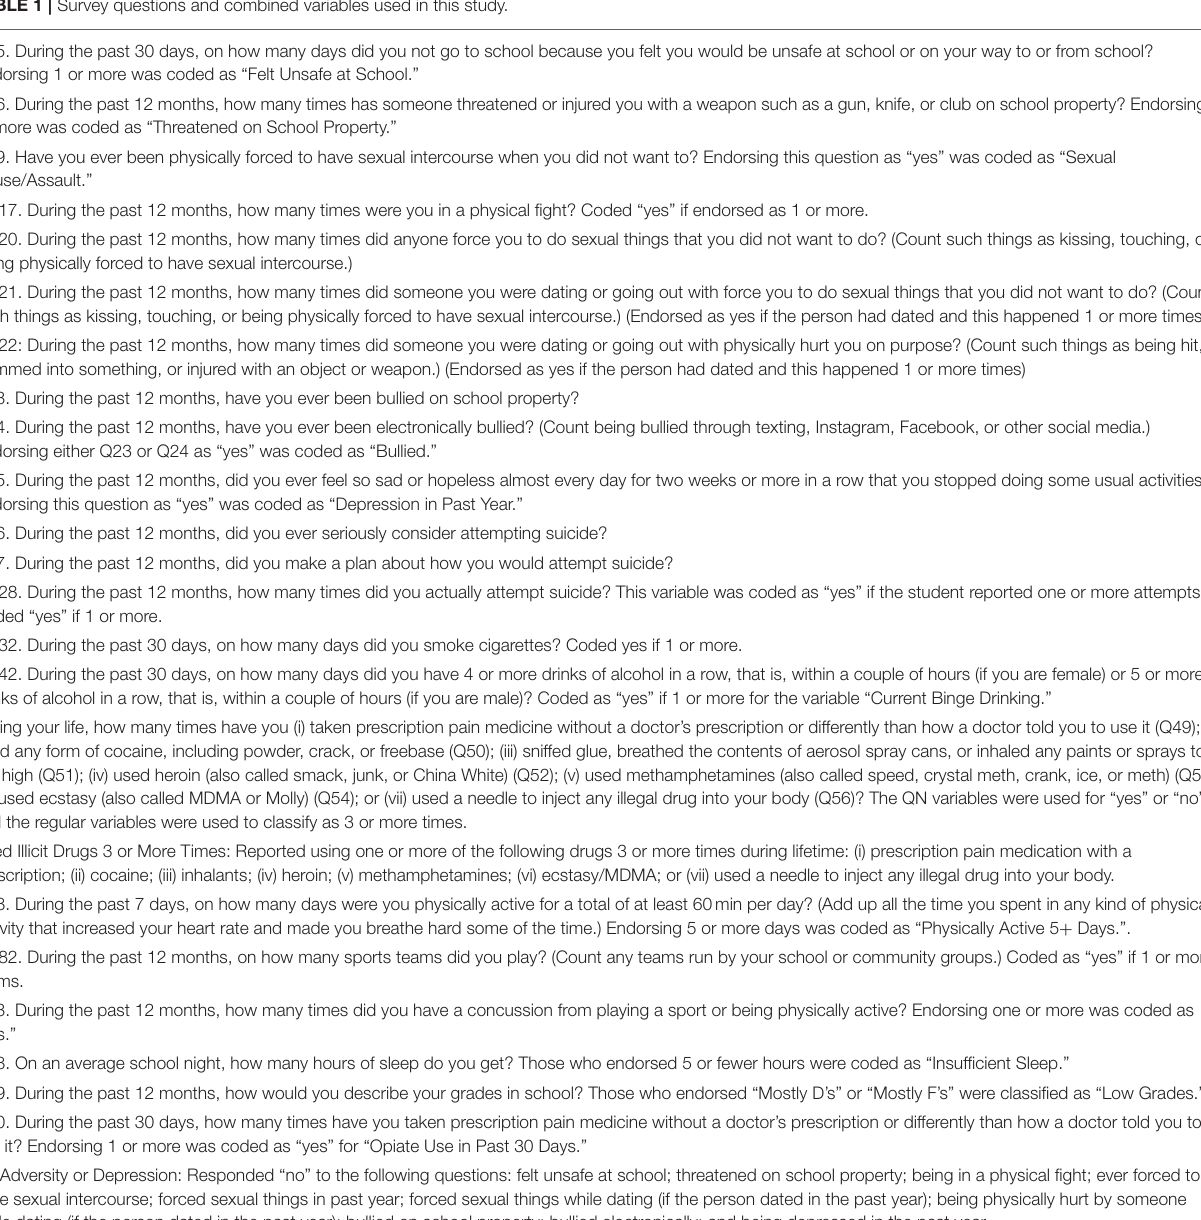
TABLE 1 | Survey questions and combined variables used in this